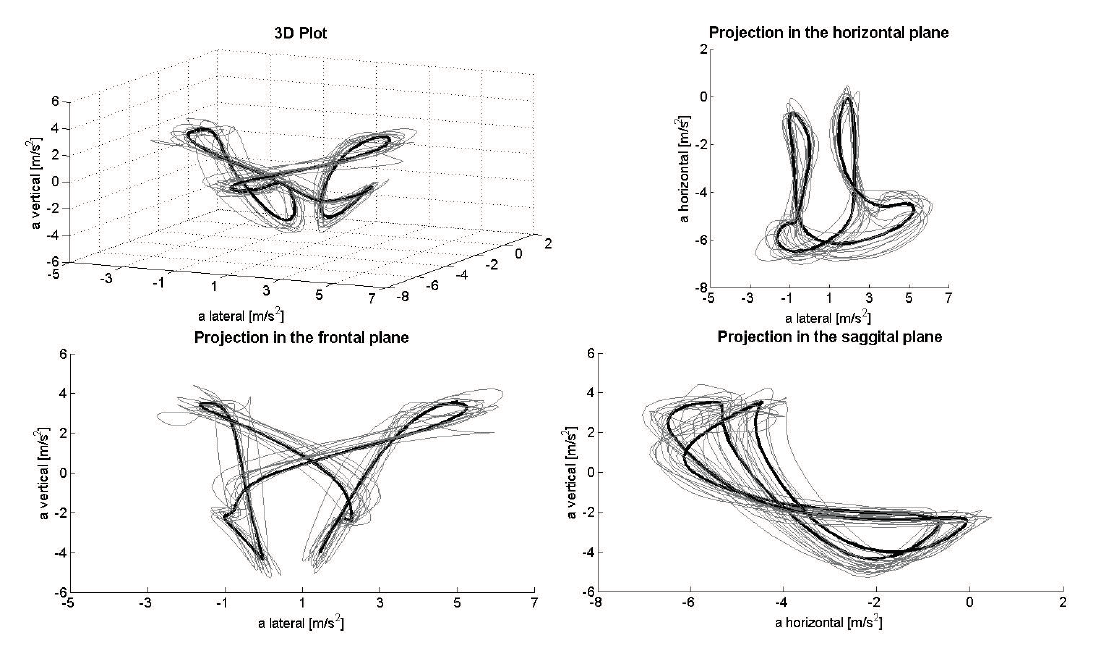
Figure 3. Acceleration data during G3 in the total space ( upper left ) and frontal ( lower left ), horizontal ( upper right ) and sagittal planes ( lower right